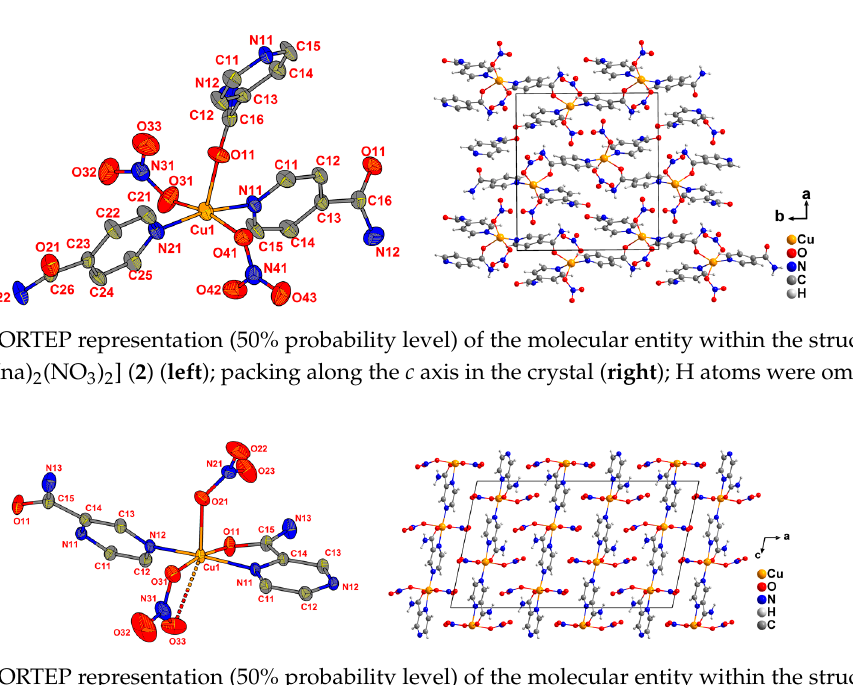
Figure 2. ORTEP representation (50% probability level) of the molecular entity within the structure of 1 ∞ [Cu(Pya)(NO 3 ) 2 ] ( 11 ) ( left ); packing along the b axis in the crystal ( right ); H atoms were omitted for clarity.